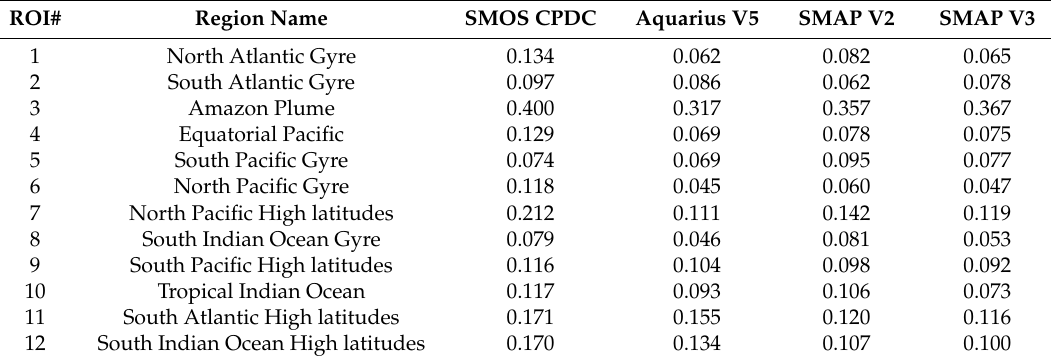
Table 8. Standard deviation (psu) of the difference between satellite and Argo